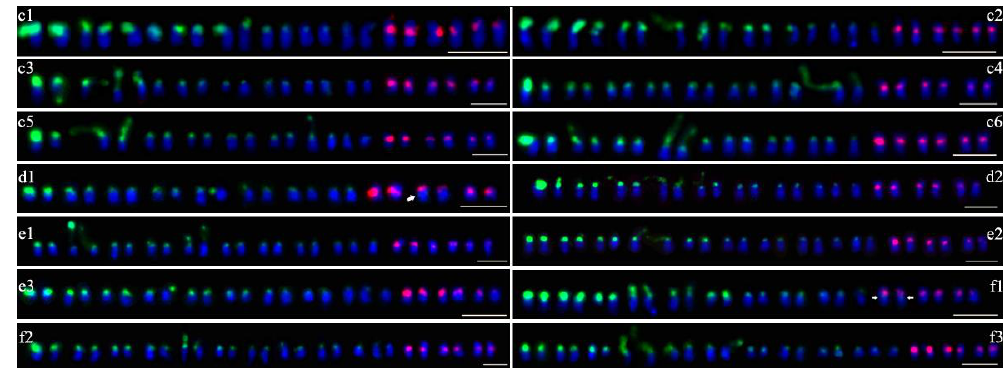
b12: Guangzishu 8. Scale bars, 5 μm.